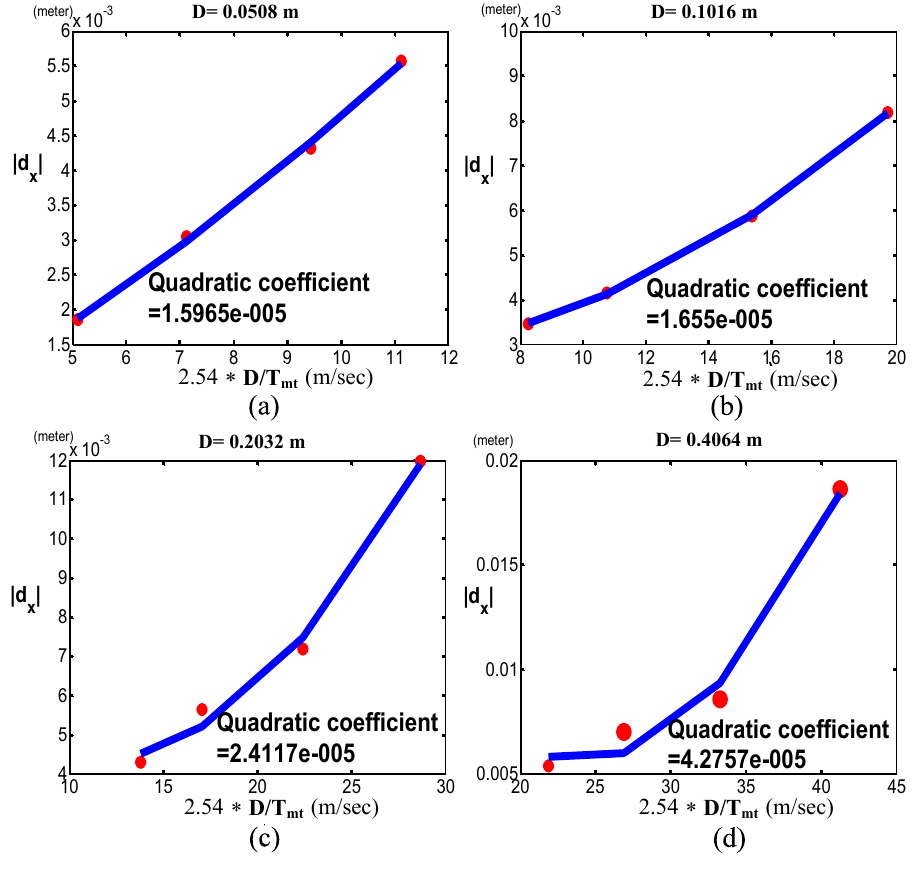
Figure 11. PUMA 560 experimental results of the Cartesian position errors of the end-effector along the x -axis ( d ) with respect to D/T ( a ) D = 0.0508 m; ( b ) D = 0.1016 m; x mt ( c ) D = 0.2032 m; ( d ) D = 0.4064